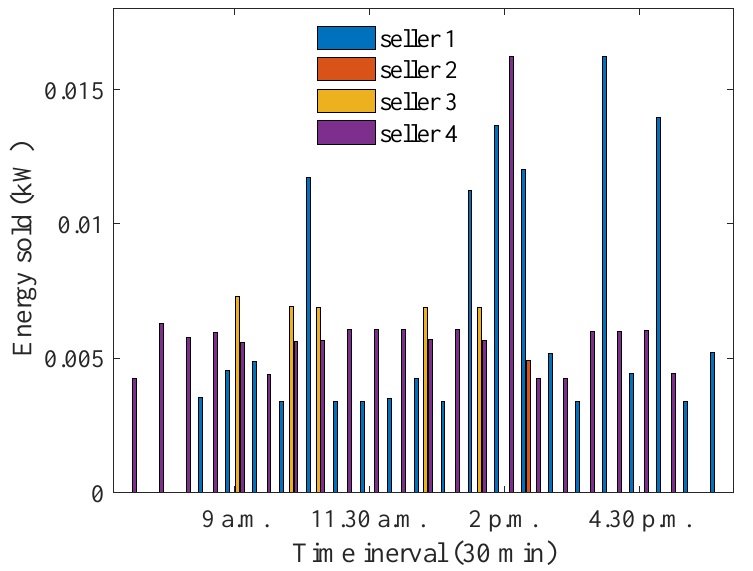
Figure 19. Optimum energy sold when distance between house 4 and the aggregator is decreased.